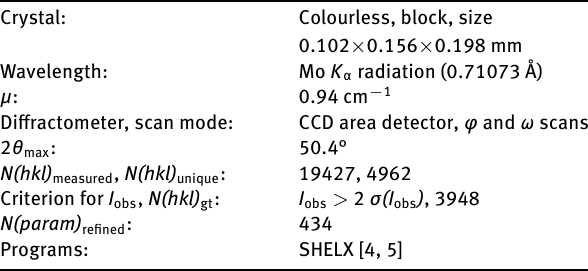
Table 1: Data collection and handling.